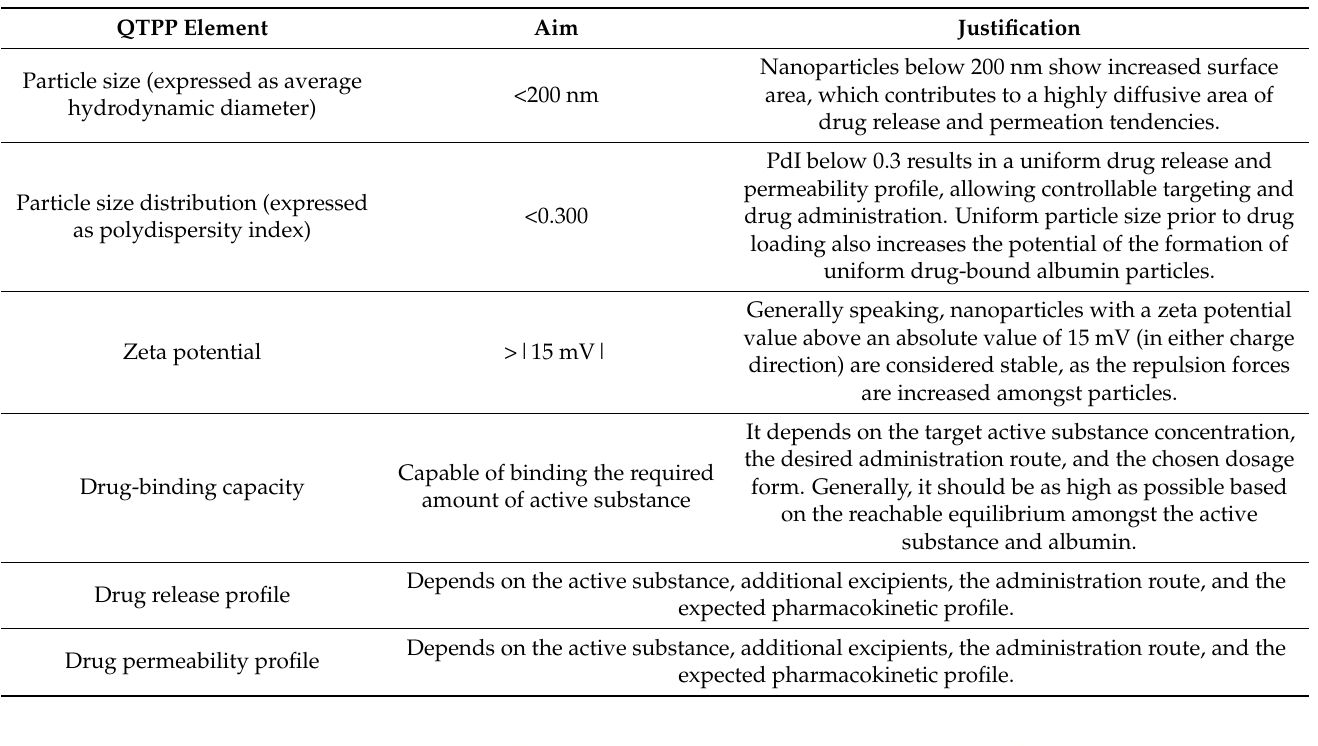
Table 3. Selected Quality Target Product Profile (QTPPs) of HSA nanoparticles with the desired aim to optimize these particles prior to drug loading.